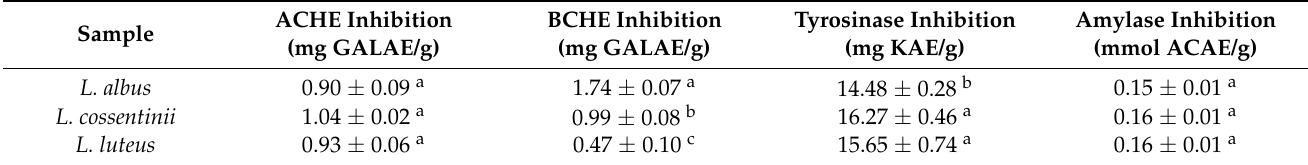
Table 3. Inhibitory activity of enzymes in seeds of three Tunisian lupin